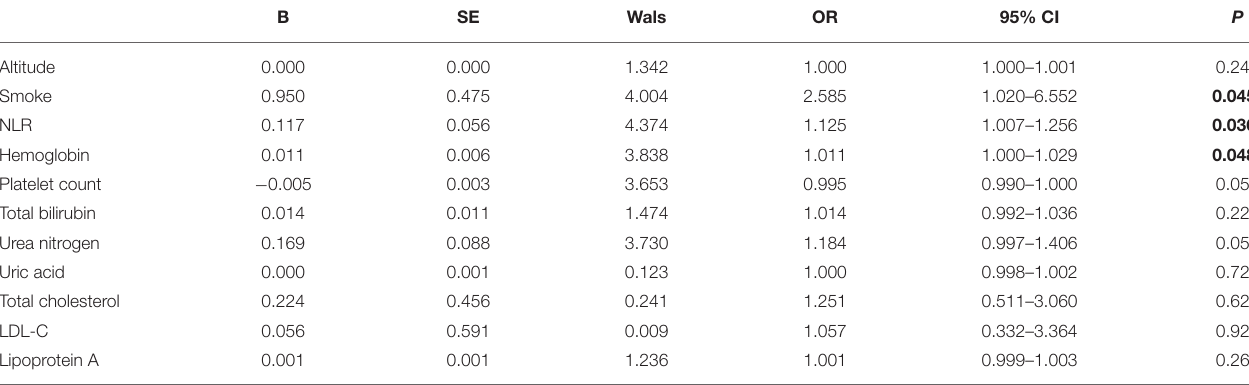
TABLE 2 | Logistic multivariate regression analysis of factors related to myocardial injury in population at high